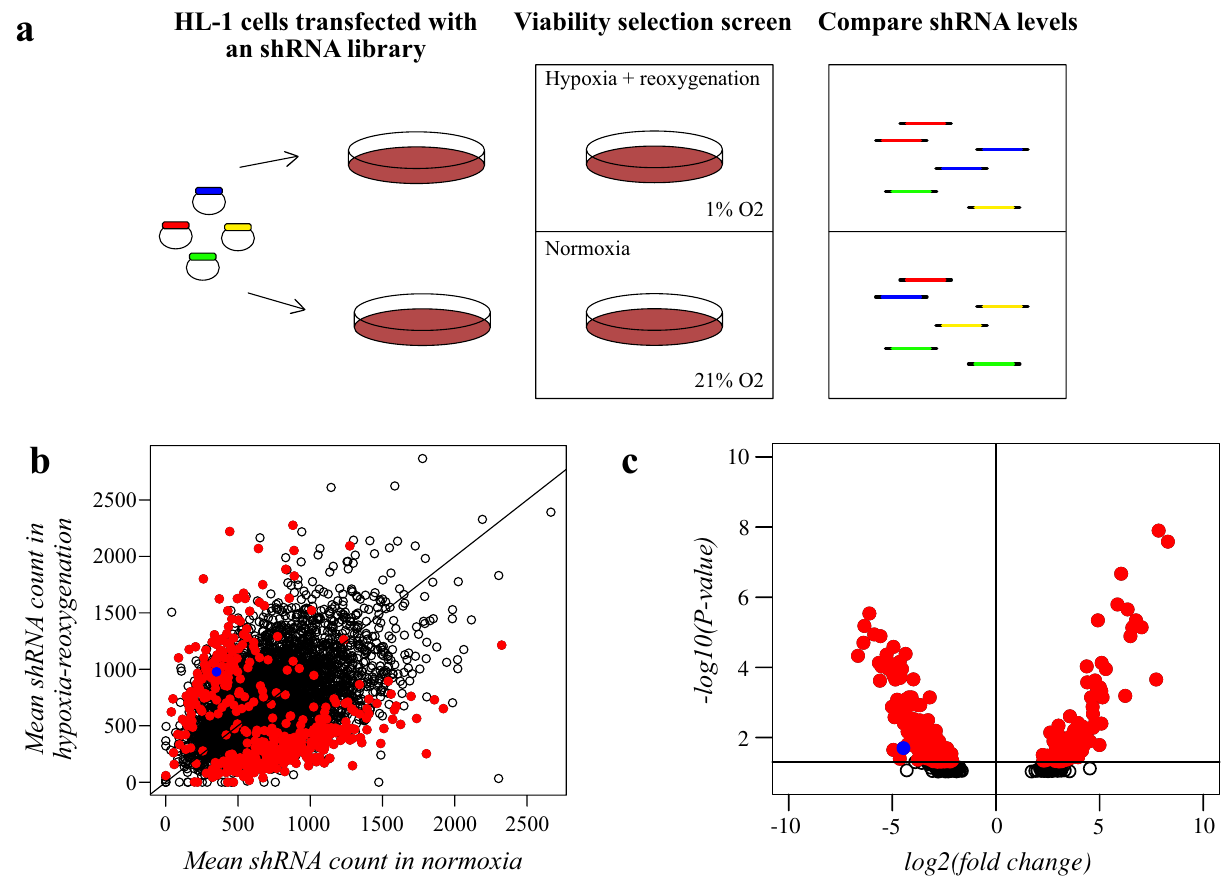
Figure 1. shRNA library screening to identify modulators of cardiomyocyte survival. ( a ) Schematic overview of the shRNA library screen. HL-1 cells were transduced with a lentiviral shRNA library targeting 4625 genes. Cells were exposed to hypoxia-reoxygenation for a viability dropout screen. As the readout, shRNA abundances were quantified with NGS. ( b ) Scatter plot illustrating the mean copy number of barcoded shRNAs for each gene after culturing of the cells in normoxia (x-axis) or in hypoxia followed by reoxygenation (y-axis). Significantly regulated genes are depicted with red dots. The dot representing the mean copy number of shRNAs targeting EGFR is indicated in blue. Line depicts the level where shRNA abundances are equal in normoxia and hypoxia- reoxygenation. ( c ) Volcano plot of log2-transformed fold-changes of mean shRNA counts in normoxic cells and in hypoxia-reoxygenation-treated cells and their respective P values from DESeq2 analysis. Significantly regulated genes are depicted with red dots. The dot representing EGFR is indicated in